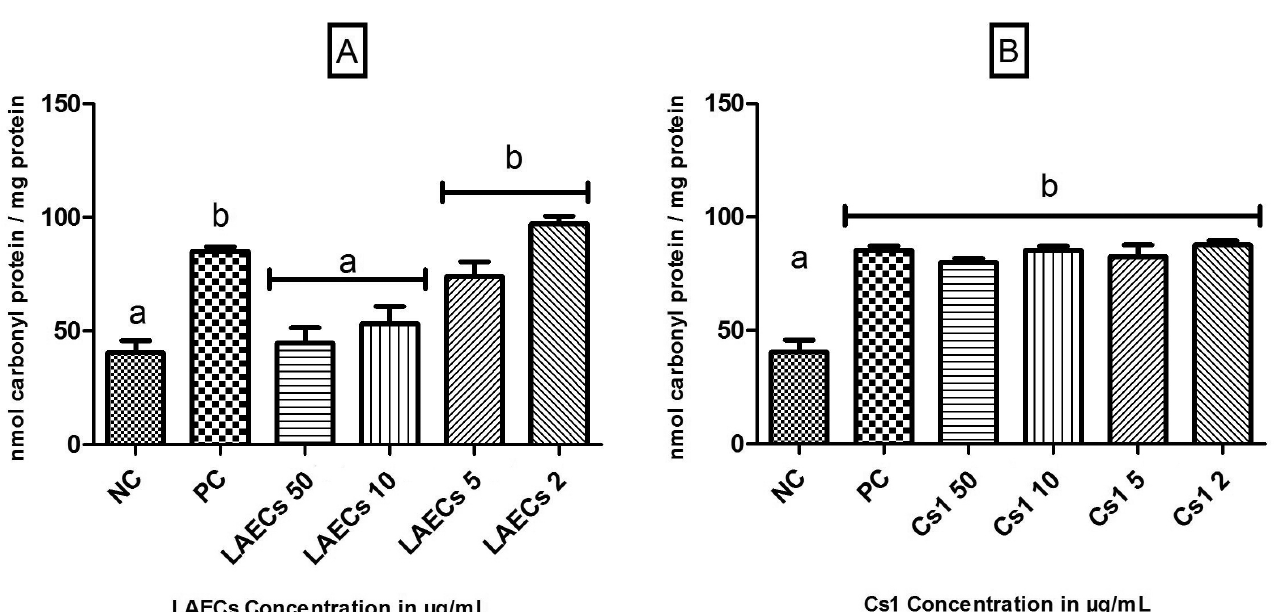
FIGURE 5 - Effects of lyophilized aqueous extract (LAECs) and raw ethanol extract (Cs1) on protein carbonylation induced by hydrogen peroxide (H O 100 μmol/L) in plasma. NC – Negative Control (phosphate buffered saline ); PC – Positive Control; (H 2 2 100 µmol/L 1 ); (A) LAECs (50, 10, 5 and 2 µg/mL); (B) Cs1 (50, 10, 5 and 2 µg/mL). Data are expressed as mean ± SD. Columns with different letters are significantly different (p<0.05).